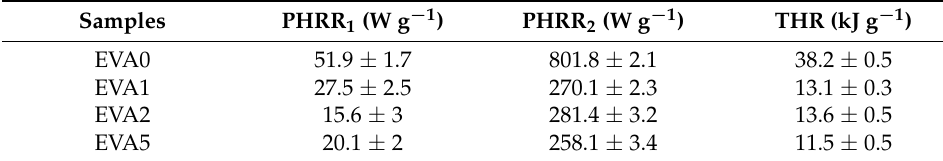
Table 4. MCC data for all